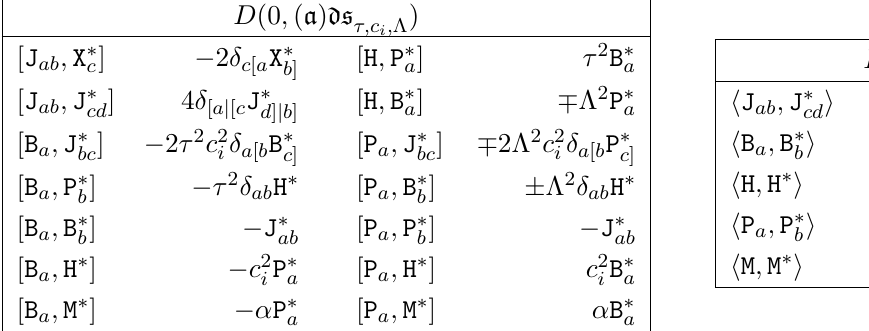
stands for B (cid:3) and P (cid:3) ; X a for a a a